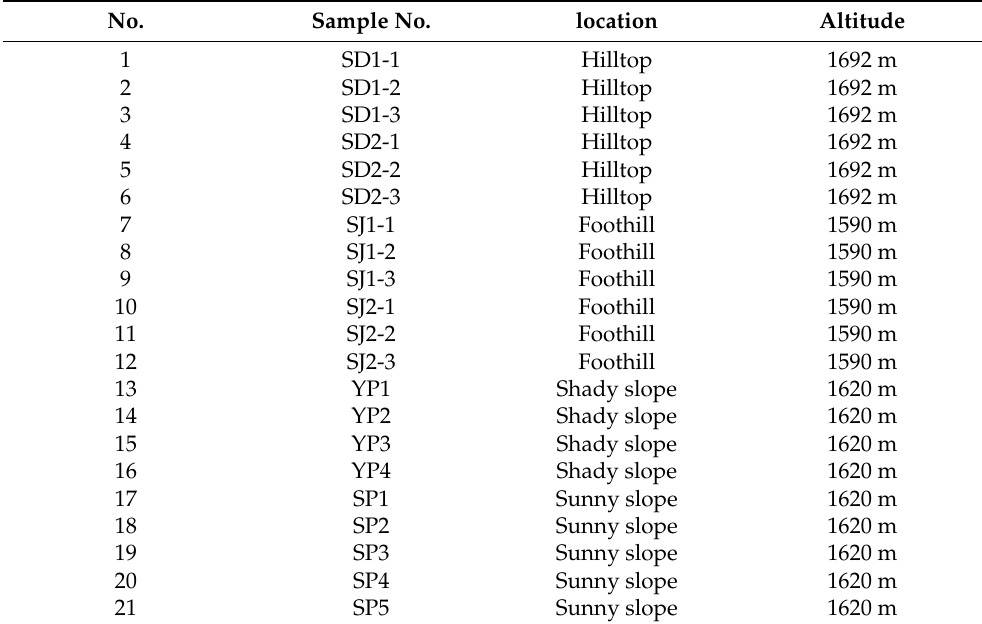
Table 1. Collected soil.